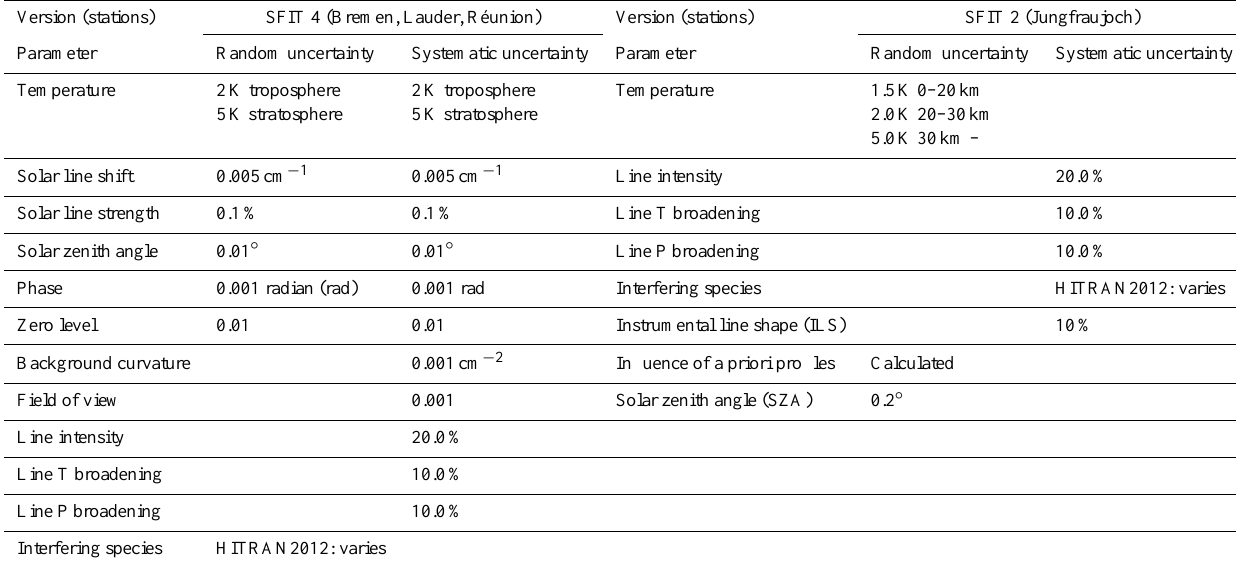
Table 3. Random and systematic uncertainties used in the error calculation.